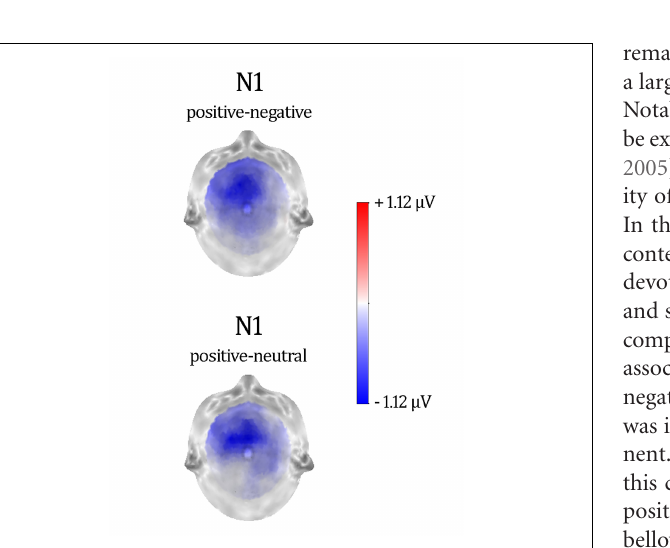
occurrence of a negative word (Harris and Pashler, 2004), or for sexually explicit words (Aquino and Arnell, 2007). Since behav- ioral correlates of attentional capture by task-irrelevant emotional pictures and faces are usually observed (e.g., Vuilleumier et